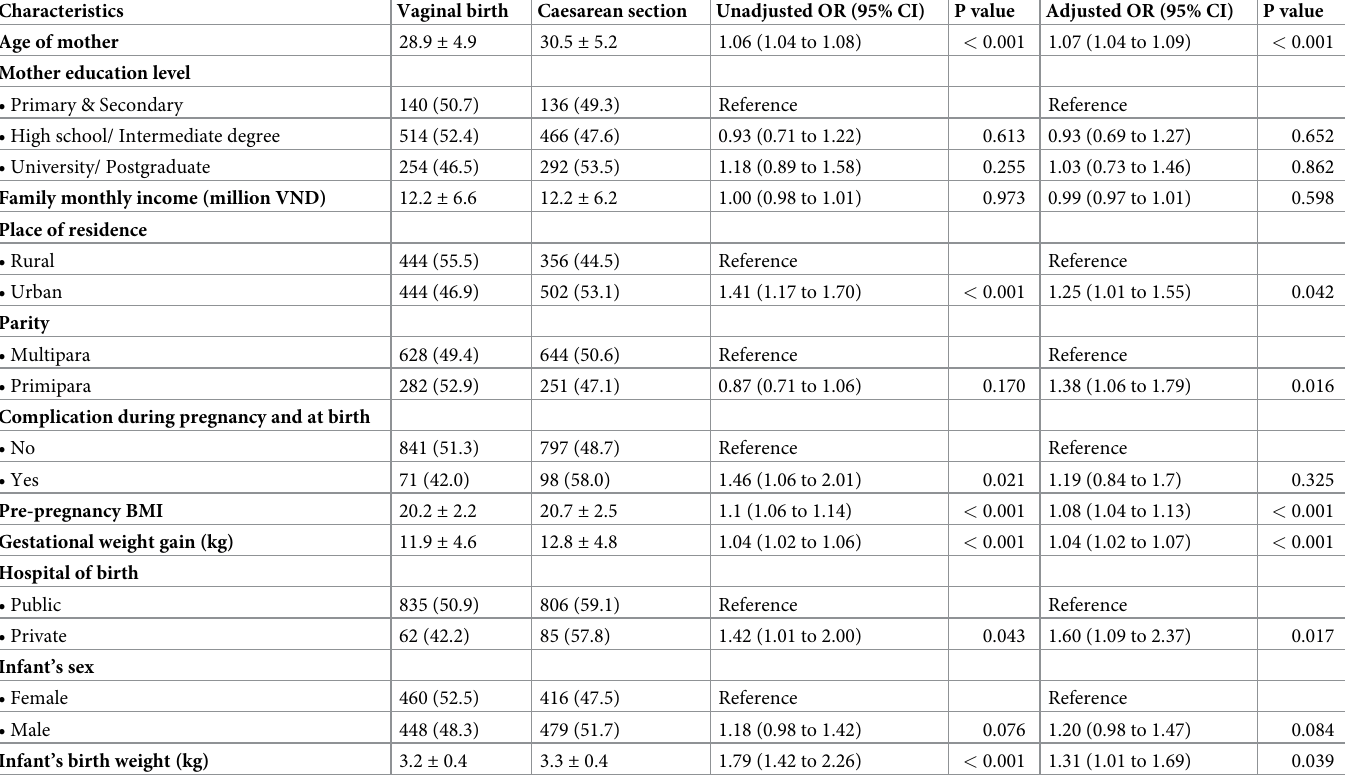
Table 2. Factors associated with caesarean section in Vietnam,